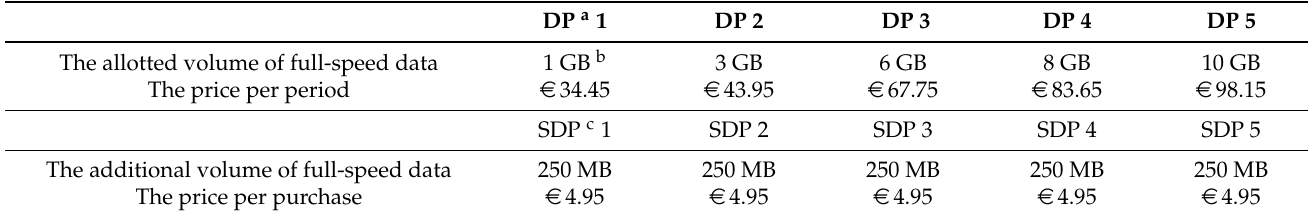
Table 3. Overview of the five data plans and supplementary data packages.